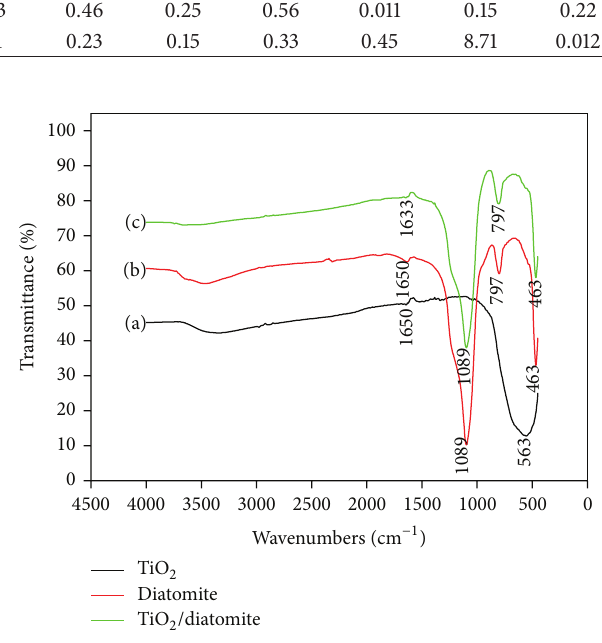
Figure 3: FTIR spectra of TiO 2 (a), diatomite (b), and TiO 2 /diatom- ite composite